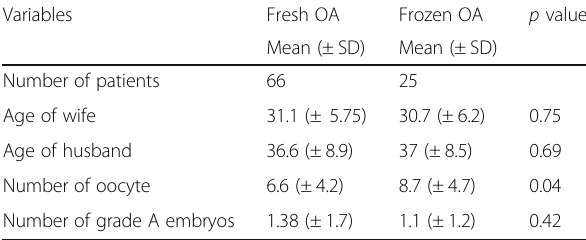
obstructive azoospermia group regarding different criteria and